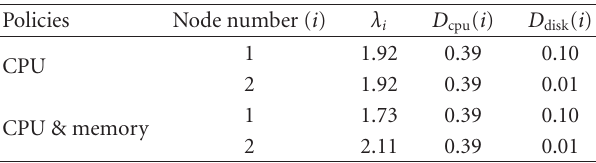
Table 1: Parameters of the queuing model.